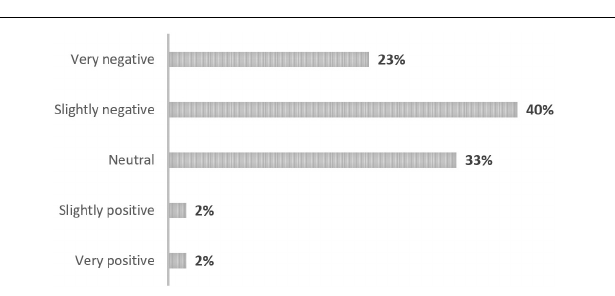
(Turkish) , (Russian) or Miminari (Japanese) .